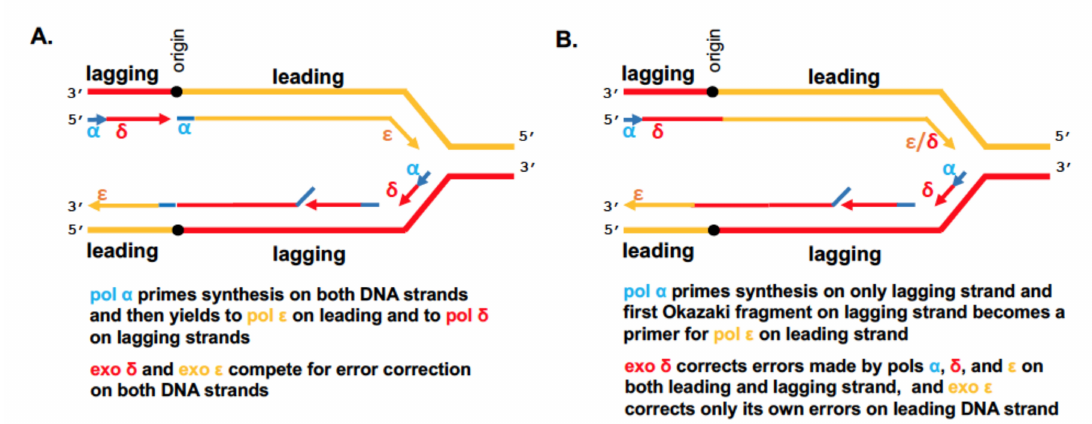
Figure 2. The replication fork seen in 1990 looks almost right in 2020. ( A ) Schematic representation of the model proposed by Morrison et al. in 1990 [29]. The bidirectional replication starts at the origin, and part of the fork moving to the left is not shown. Primase / Pol α synthesizes short RNA / DNA primers extended by pol ε on the leading strand and by pol δ on the lagging strand. Most of these primers are excised from the newly synthesized DNA [31]. Proofreading exonucleases associated with pol δ and ε have access to 3 (cid:48) -DNA ends on both strands and thus compete to proofread replication errors [24]. The mismatch repair step is not shown for simplicity. ( B ) The current vision of replication fork. Pol ε does not participate in any transactions on the lagging DNA strand. Pol δ and pol α contribute to the replication of both strands. It is estimated that only 1.5% of DNA synthesized by primase-pol α is retained in newly synthesized DNA in humans [32]. Moreover, 80% of the leading strand is synthesized by pol ε . Pol δ synthesized DNA is at least 18% of the leading [33], and more than 90% of lagging DNA strands